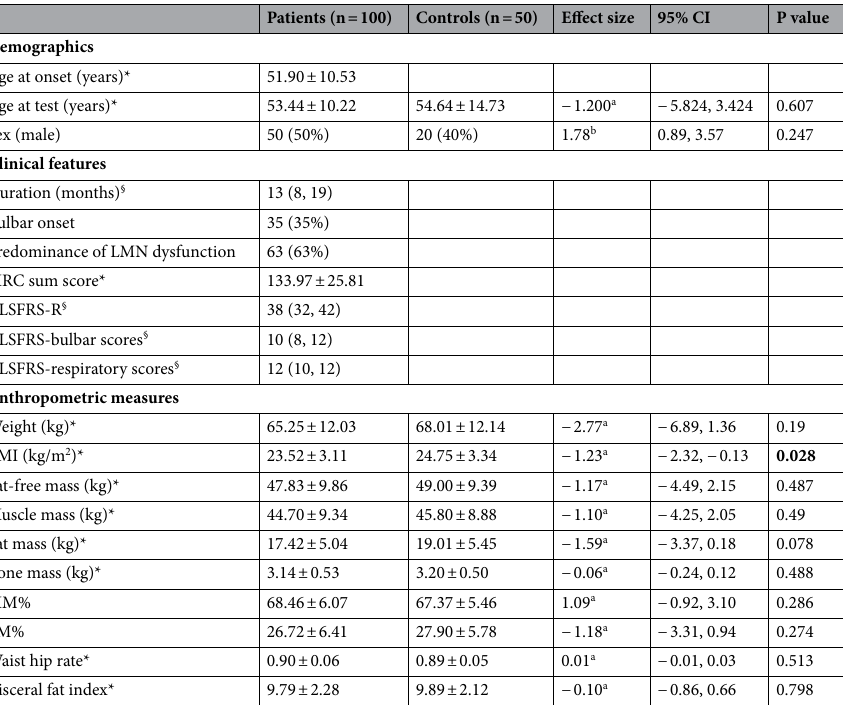
Table 1. Clinical features of patients and the comparison of nutritional parameters between patients and controls. BMI Body Mass Index, ALSFRS-R ALS Functional Rating Scale, LMN lower motor neuron, MM% proportion of muscle mass, FM% proportion of fat mass. *Data presented as mean ± standard deviation. § Data presented as median (IQR). a Mean difference. b Odd ratio. P-value < 0.05 is shown in